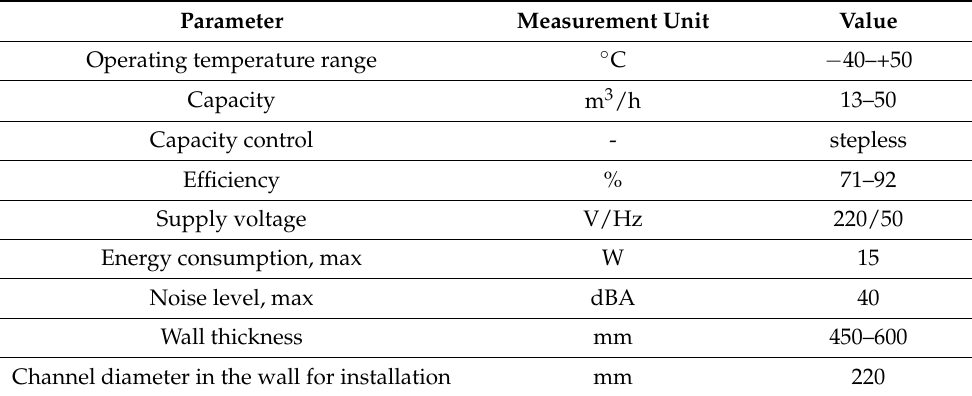
Table 1. Technical specifications of the UVRK-50 device reported by the manufacturer.